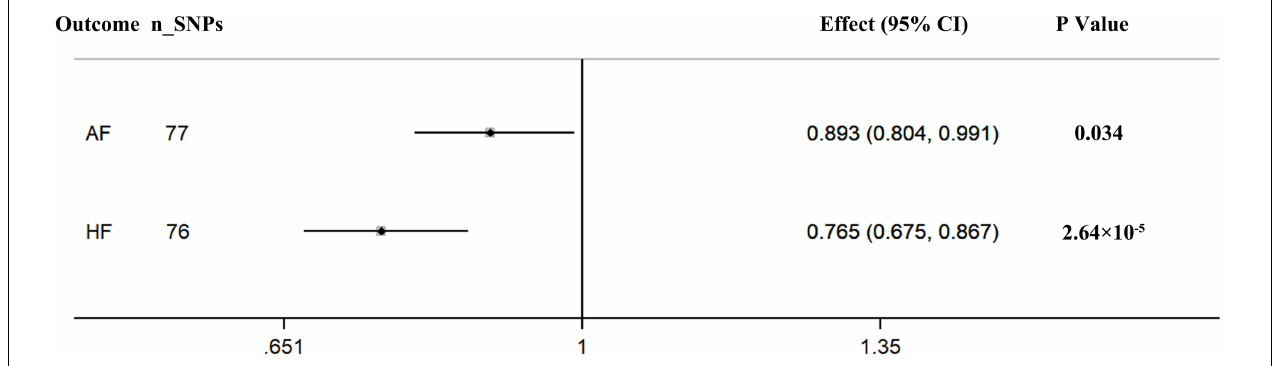
FIGURE 2 | Causal associations between continuous sleep duration and AF and HF. The number of genetic variants, effects, 95% confidence intervals, and P values of associations are contained. n_SNPs, the number of SNPs used as instrumental variables; Effect, the combined causal effect; CI, confidence interval; P value, P value of the causal